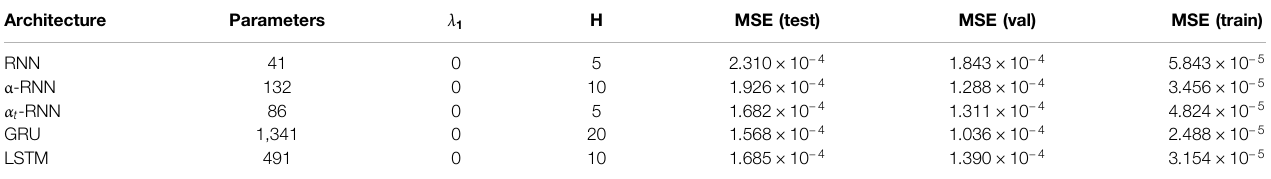
TABLE 2 | The ten-step ahead forecasting models for VWAPs are compared for various architectures using time series cross-validation. The half-life of the α -RNN is found to be 2.398 periods ( (cid:1) α (cid:1) 0 . 251 ).